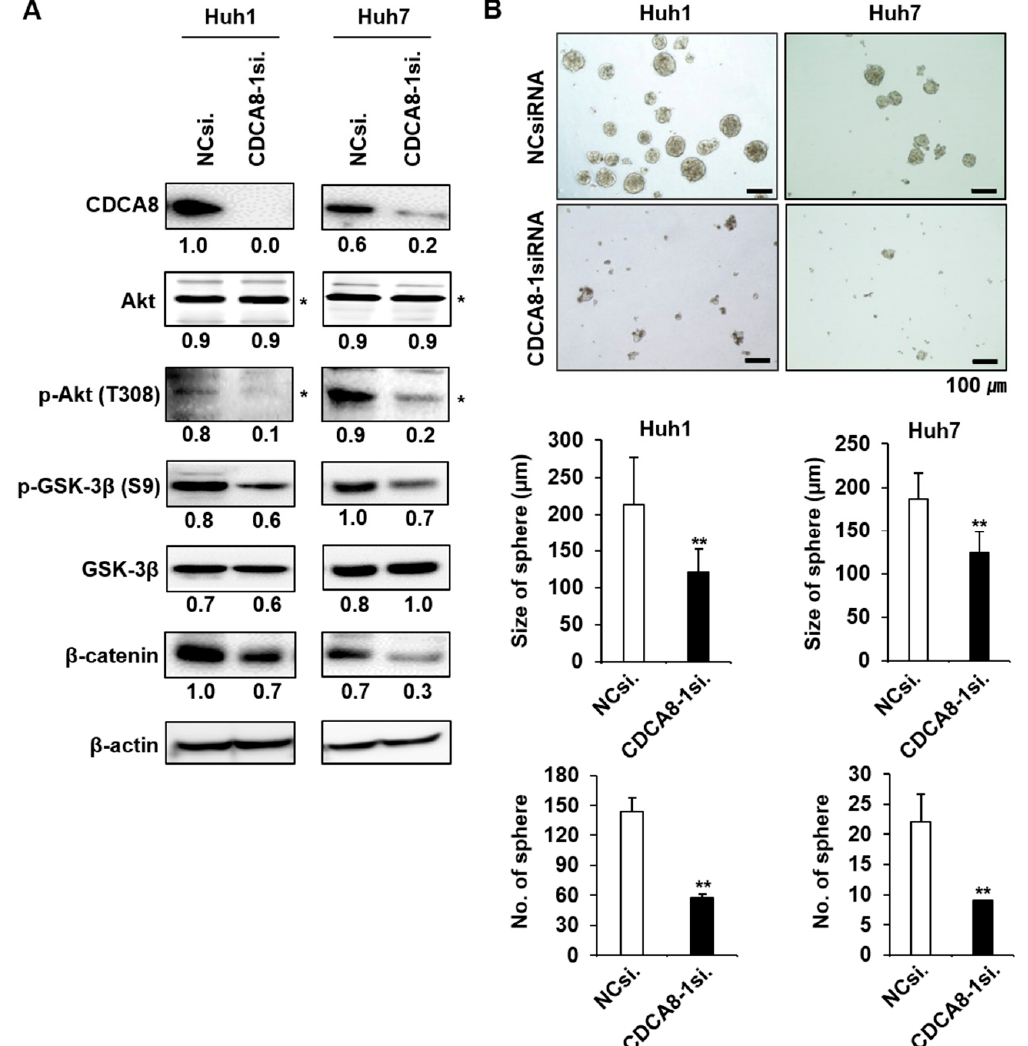
Figure 7. Silencing of CDCA8 inactivates AKT/ β –catenin signaling and inhibits sphere formation. ( A ) Western blot analysis of CDCA8 and the indicated proteins functionally involved in AKT/ β –catenin signaling. ( B ) Detection of sphere formation in HCC cells treated with NCsiRNA or CDCA8-1siRNA. * exact position of target protein band when measured with molecular weight markers (refer to Supplementary Figure S7). ** p < 0.01 vs. control. Scale bar = 100 μ m.